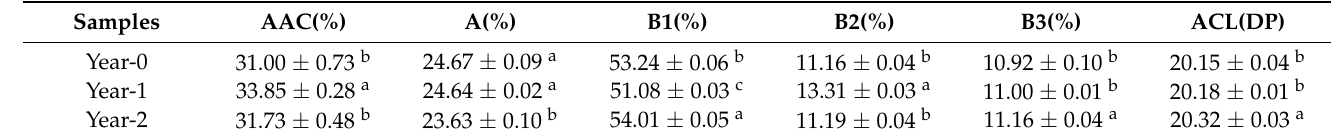
Table 3. Chain length distribution variation of rice amylopectin in storage.